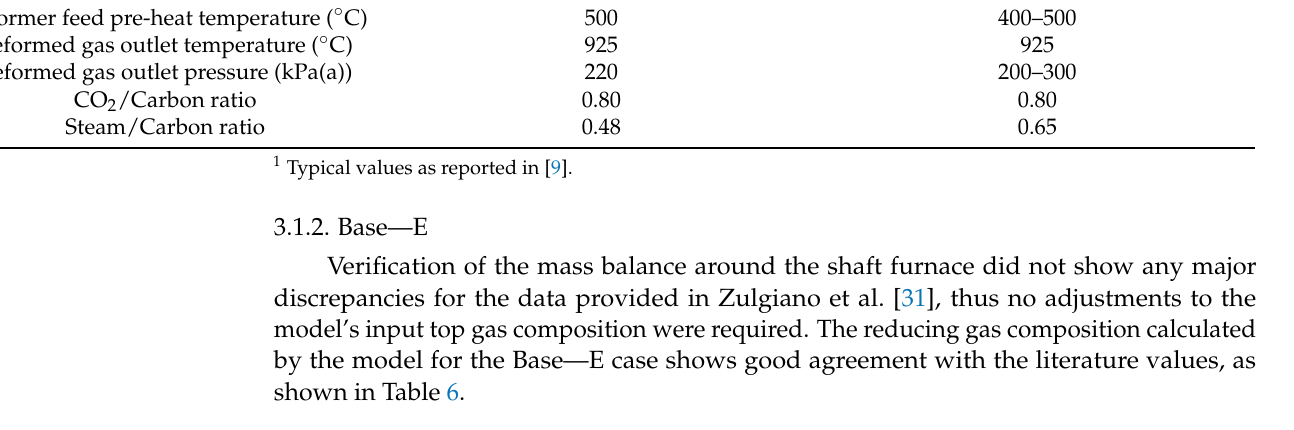
Table 6. Comparison of Base—E model boundaries at shaft furnace to